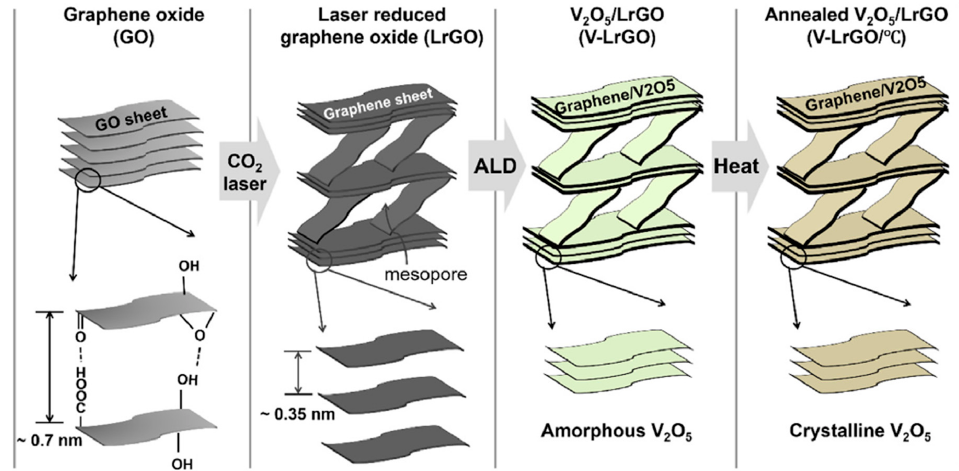
Figure 4. Schematic illustration for the fabrication process of the multilayered graphene (i.e., LrGO) and amorphous or crystalline V 2 O 5 coated LrGO. Firstly, the prepared GO was reduced by a home engraver equipped with a CO 2 laser. Then, the LrGO was coated with amorphous V 2 O 5 by a low- temperature ALD process, followed by annealing at high temperatures. Reprinted with permission from Ref. [82]. Copyright 2020 Elsevier.